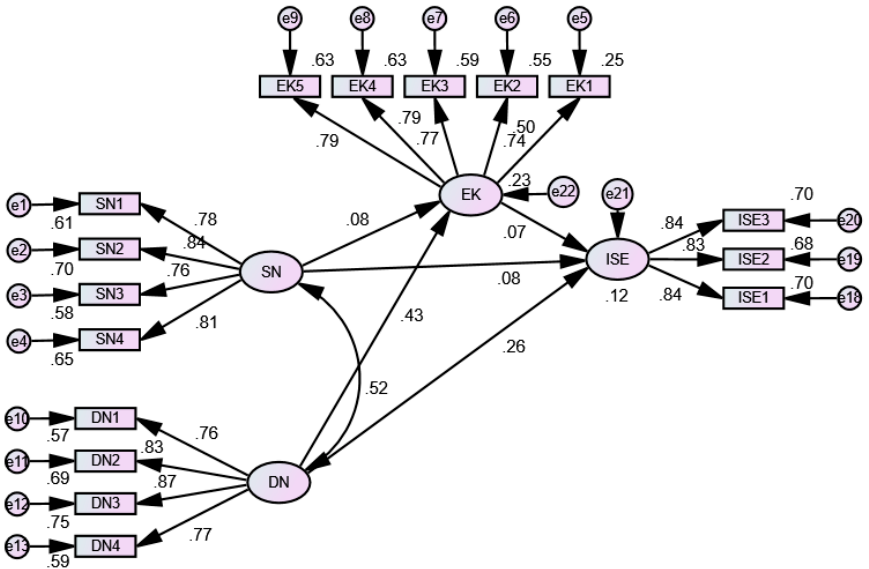
Figure 6. Mediation analysis for DR.